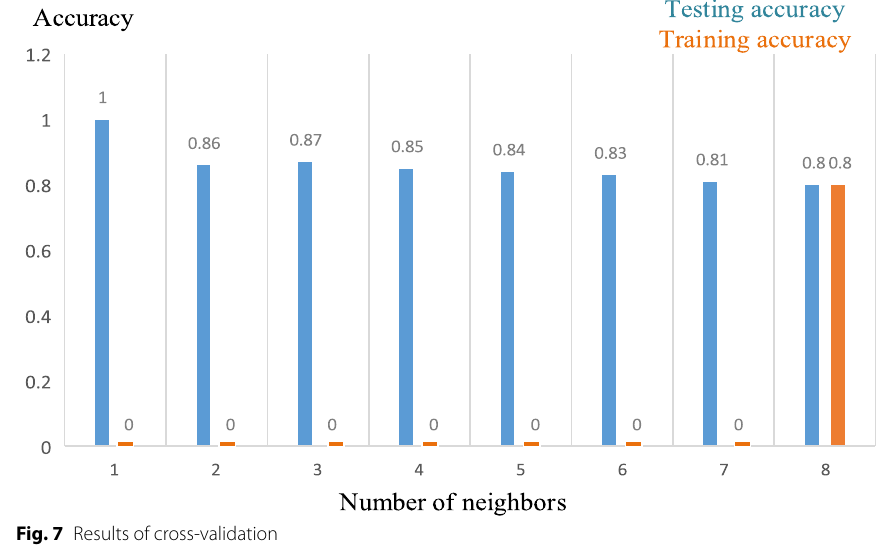
Fig. 7 Results of cross-validation